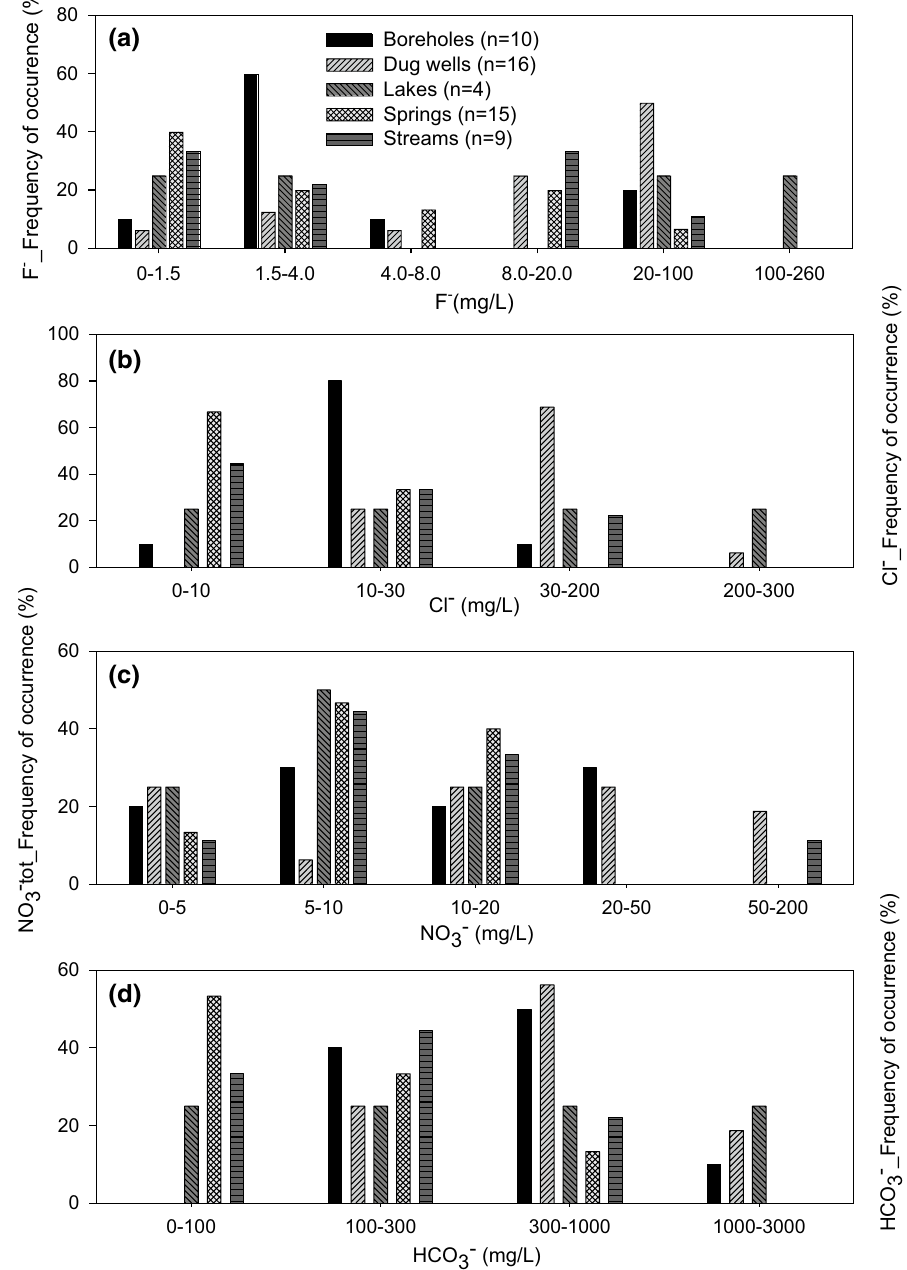
Fig. 8 Major anion distribution in different water